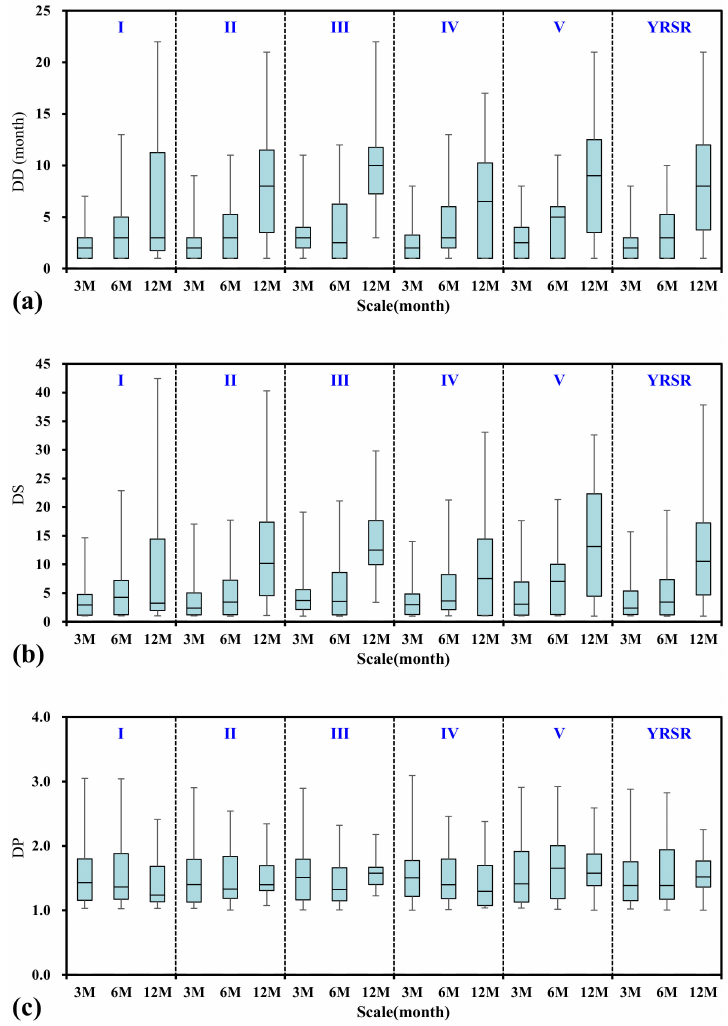
Figure 10. The box-whisker plots for drought characteristics: ( a ) drought duration, ( b ) drought severity, and ( c ) drought peak. I–V represent Togton River Basin, Middle stream, Downstream, Dam River Basin, and Qumar River Basin,